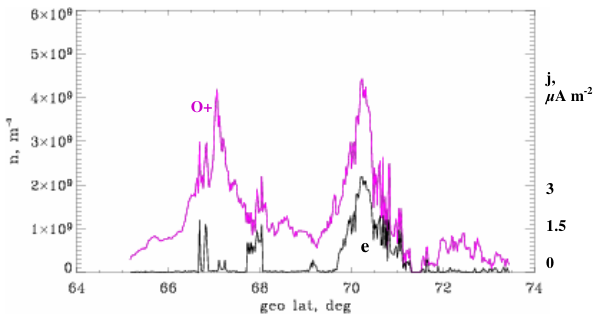
corresponds to the discrete arc which is moving southward. Red